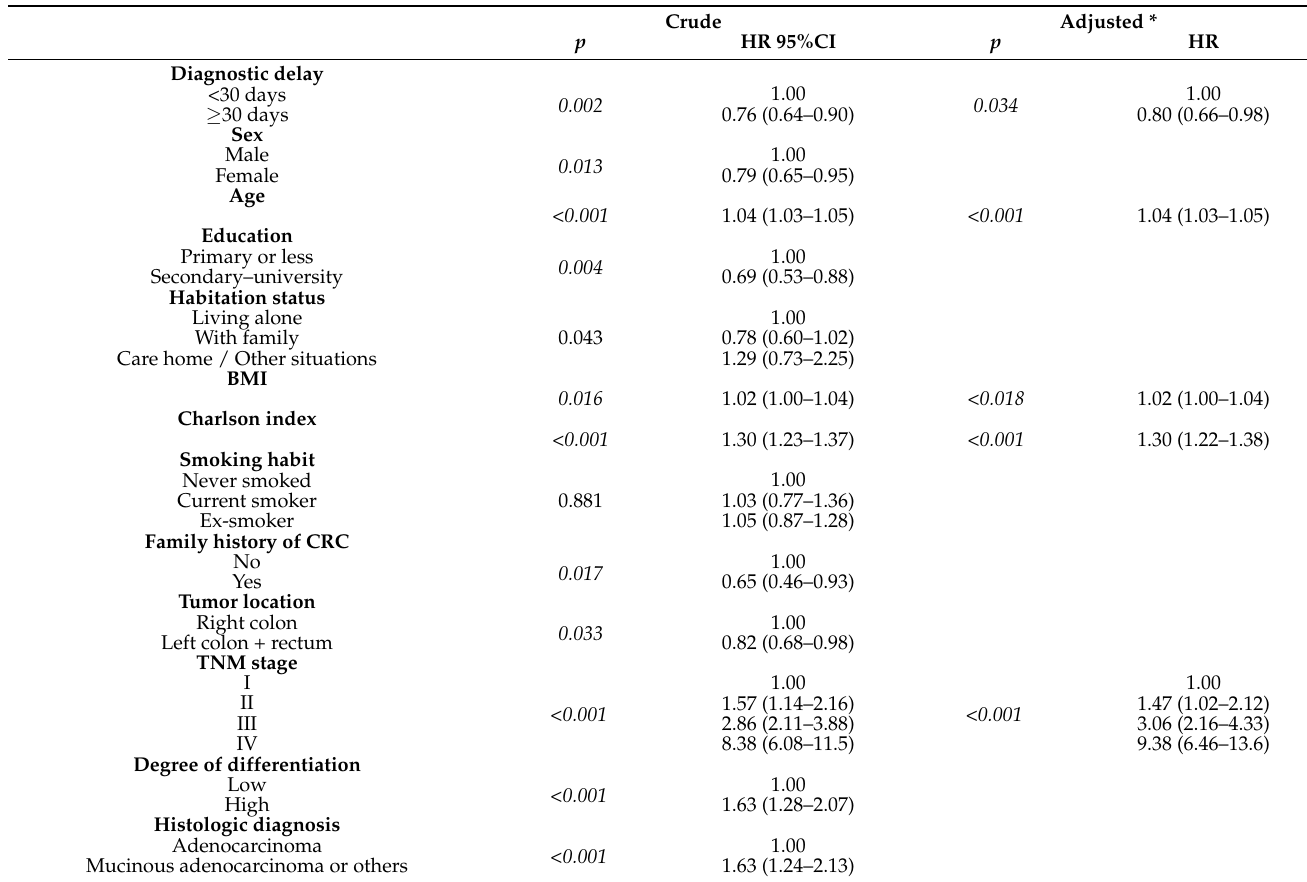
Table 3. Crude and adjusted overall survival analysis using the Cox